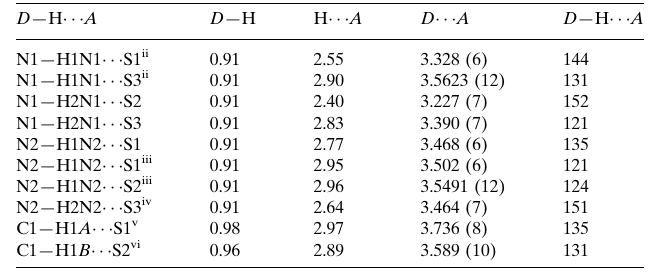
Hydrogen-bond geometry (A˚ , (cid:3)